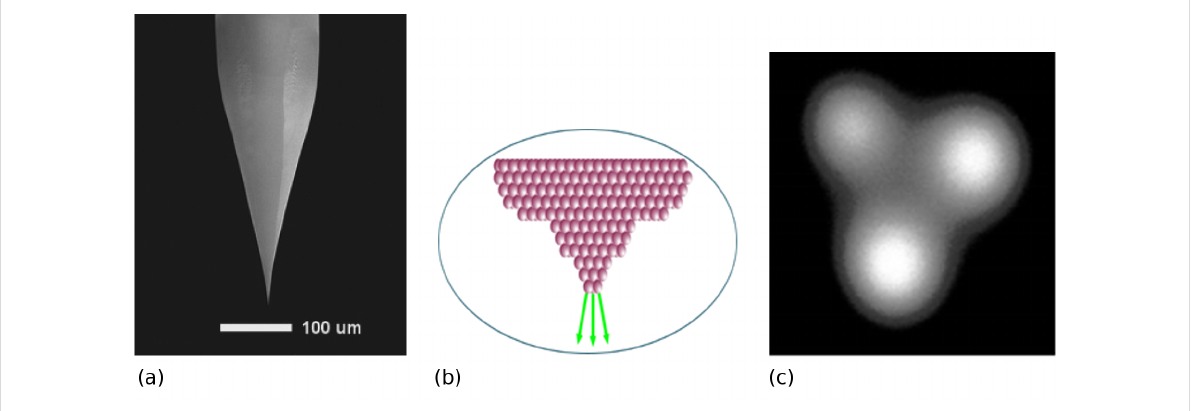
Figure 1: (a) SEM image of ALIS gas field ion source, produced with permission of [24], copyright 2010 Japanese Journal of Applied Physics. (b) Principle of operation of ALIS. (c) W atom trimer emitter at tip providing single atom emitter (ion microscope image obtained by Dr S. A. Boden at Southampton